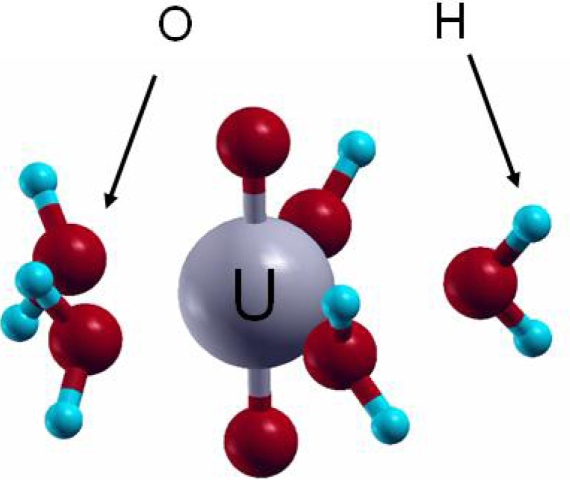
Pentahydrated uranyl structure [UO2(H2O)5]2+.